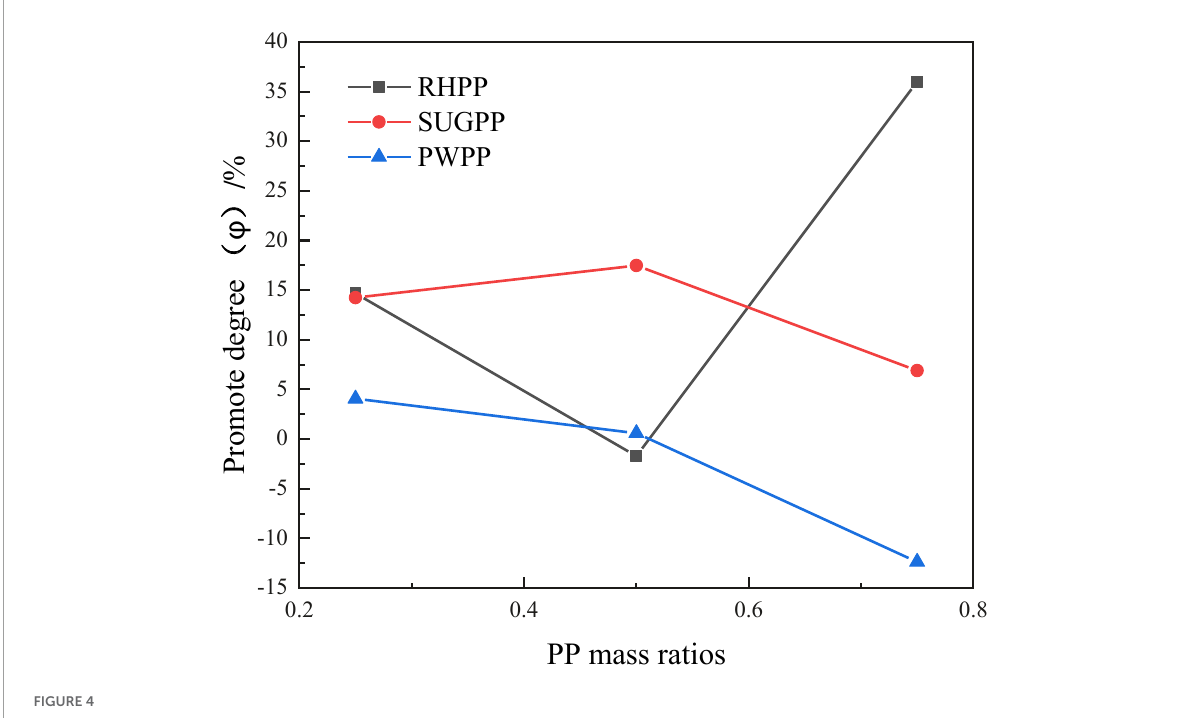
FIGURE4 Deviations of char between experimental and calculated.